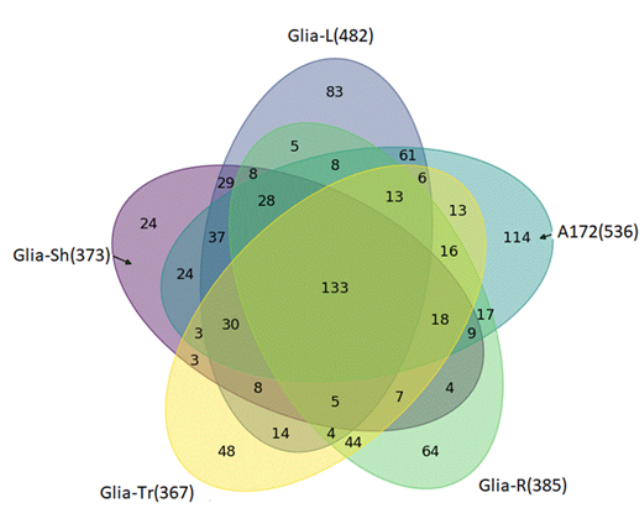
Figure 4. Venn diagram for proteins detected in all the 5 samples of exosomes.